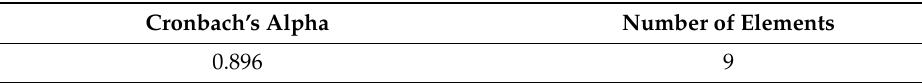
Table 7. Reliability value of the scale.